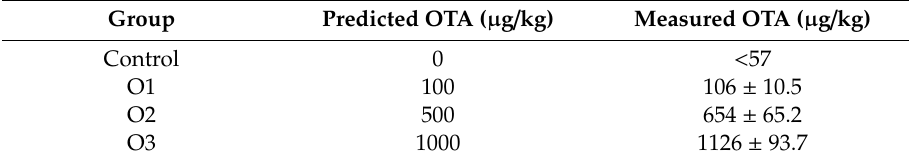
Table 1. Predicted and measured ochratoxin A concentration in the complete